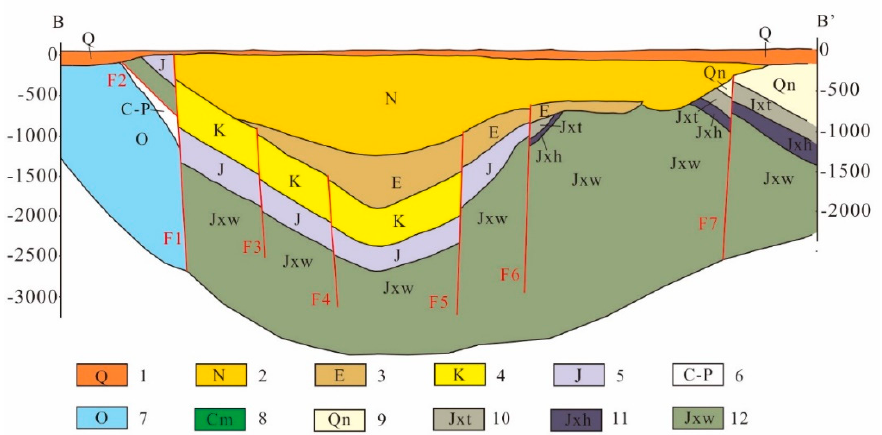
Figure 3. Profile showing the Beijing depression, section location is indicated in Figure 2. 1—Quaternary System; 2—Neogene System; 3—Palaeogene System; 4—Cretaceous System; 5—Jurassic System; 6—Carboniferous System and Permian System; 7—Ordovician System; 8—Cambrian System;